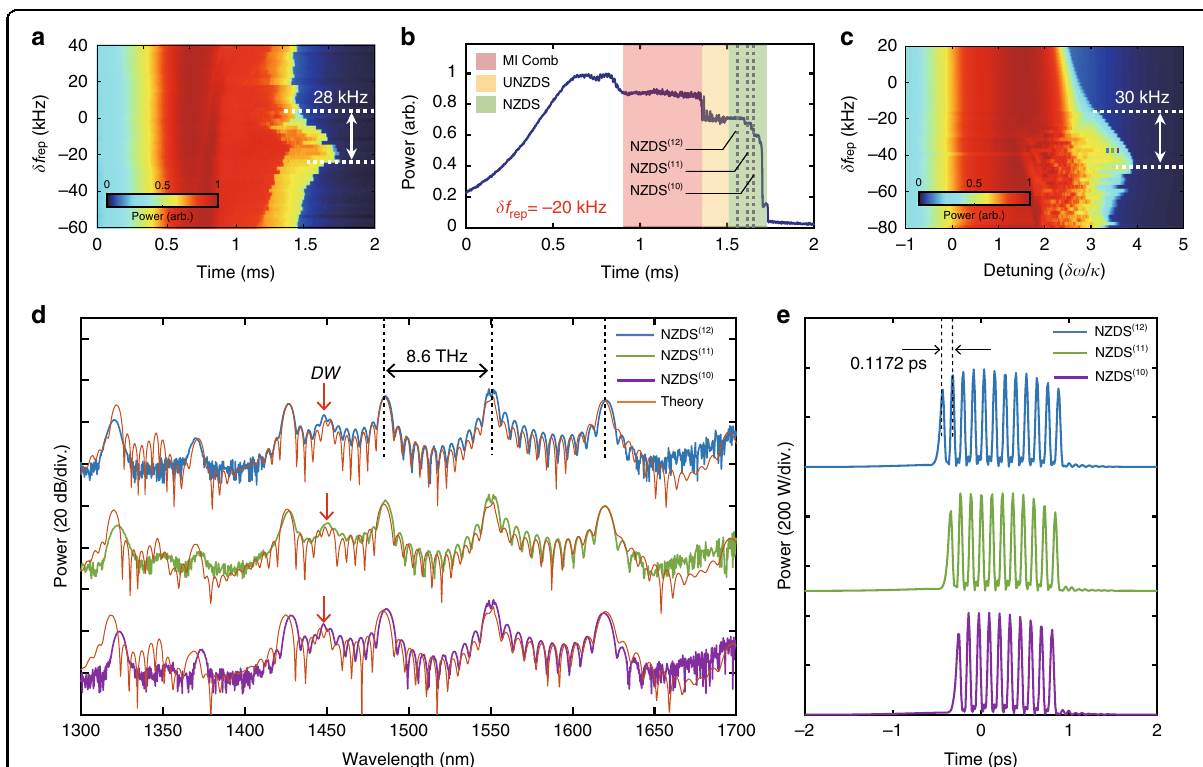
Fig. 5 Observation of tightly bound temporal structures in NZDS(10-12) states. a Contour plot of the resonator transmission at different desynchronization value of δ f rep . b Transmission curve for δ f rep = – 20 kHz. The broadband MI state, unstable NZDS (UNZDS) state and NZDS state are indicated by the red, yellow and green areas, respectively. Gray dashed lines mark the different step positions of the NZDS state demonstrated in d . c Simulated NZDS step pro fi les as a function of detuning and desynchronization frequency. The color map represents intracavity normalized power. d Experimentally obtained microcomb spectra at different NZDS states, along with the spectrum simulation results (orange curve). These three states are also marked by blue, green and purple points in ( c ). The dispersive waves are marked by red arrows in ( d ). The corresponding temporal simulation results are presented in ( e